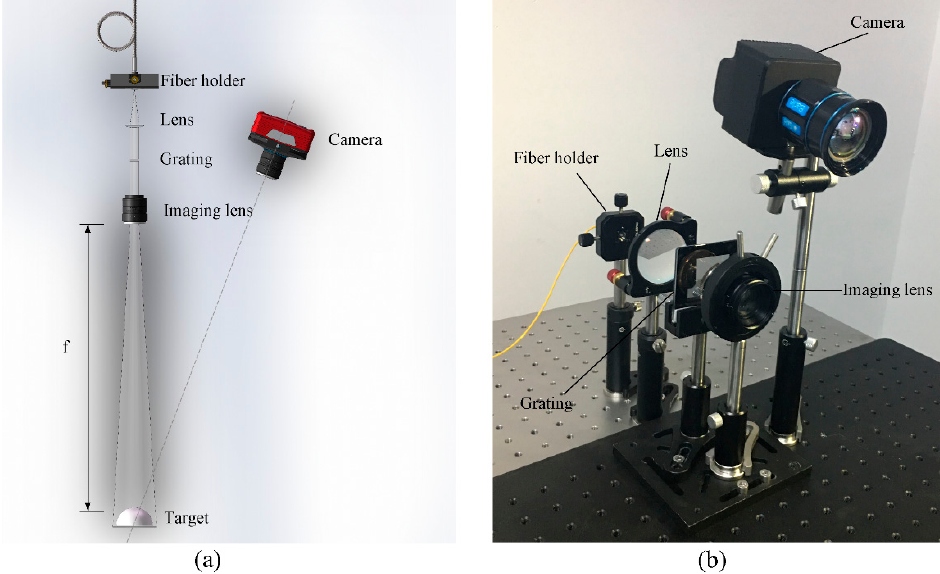
Figure 2. ( a ) Schematic of the three-dimensional (3D) shape reconstruction system. ( b ) Photograph of the 3D shape reconstruction system.